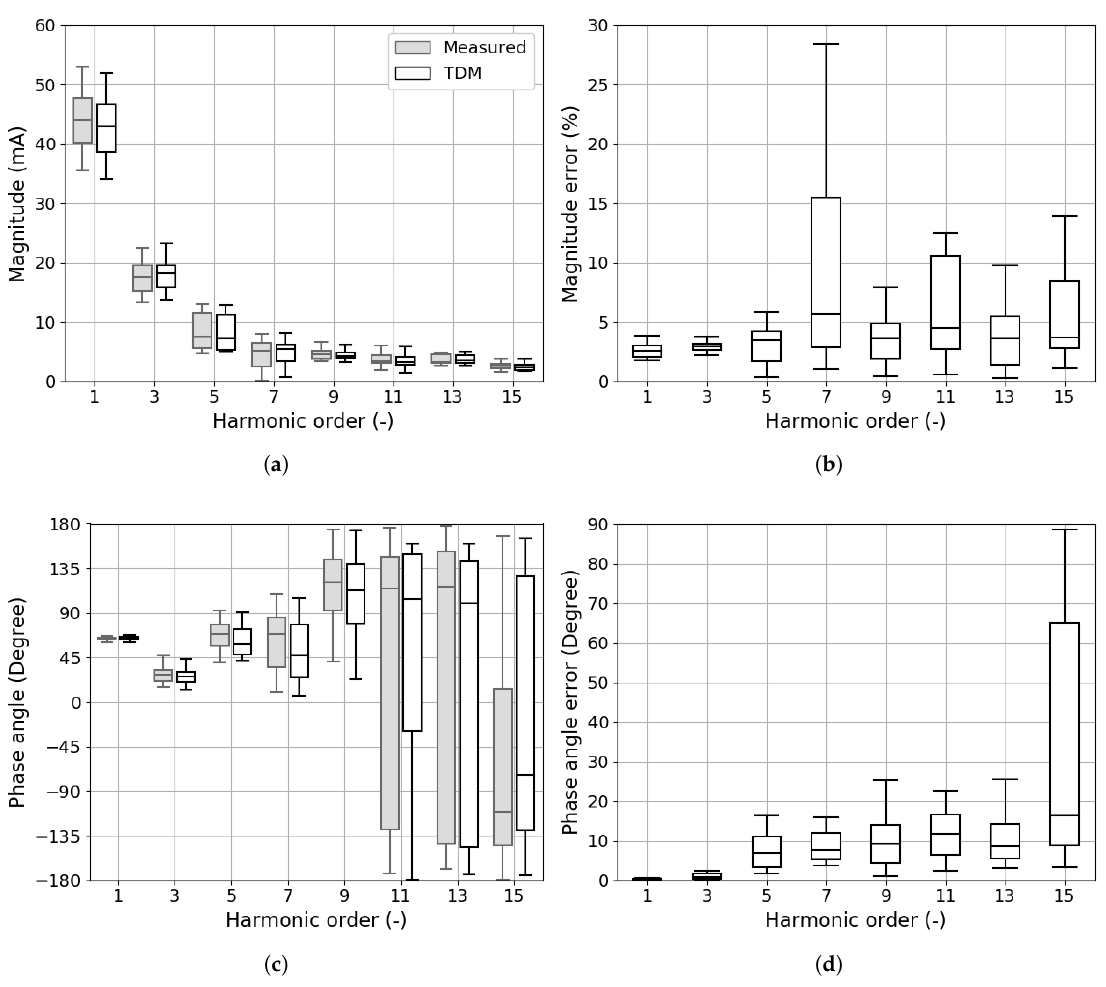
Figure 5. LED Type B: Comparison of the time-domain model (TDM) and the measured data for all test points: ( a ) Magnitude; ( b ) Magnitude error; ( c ) Phase angle; ( d ) Phase angle